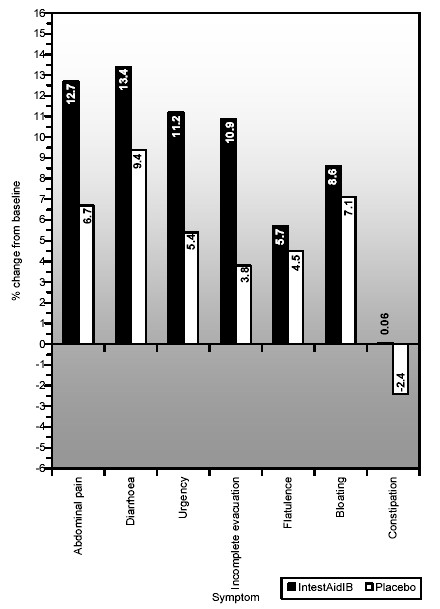
bar chart showing percentage change from baseline to placebo and experimental conditions.